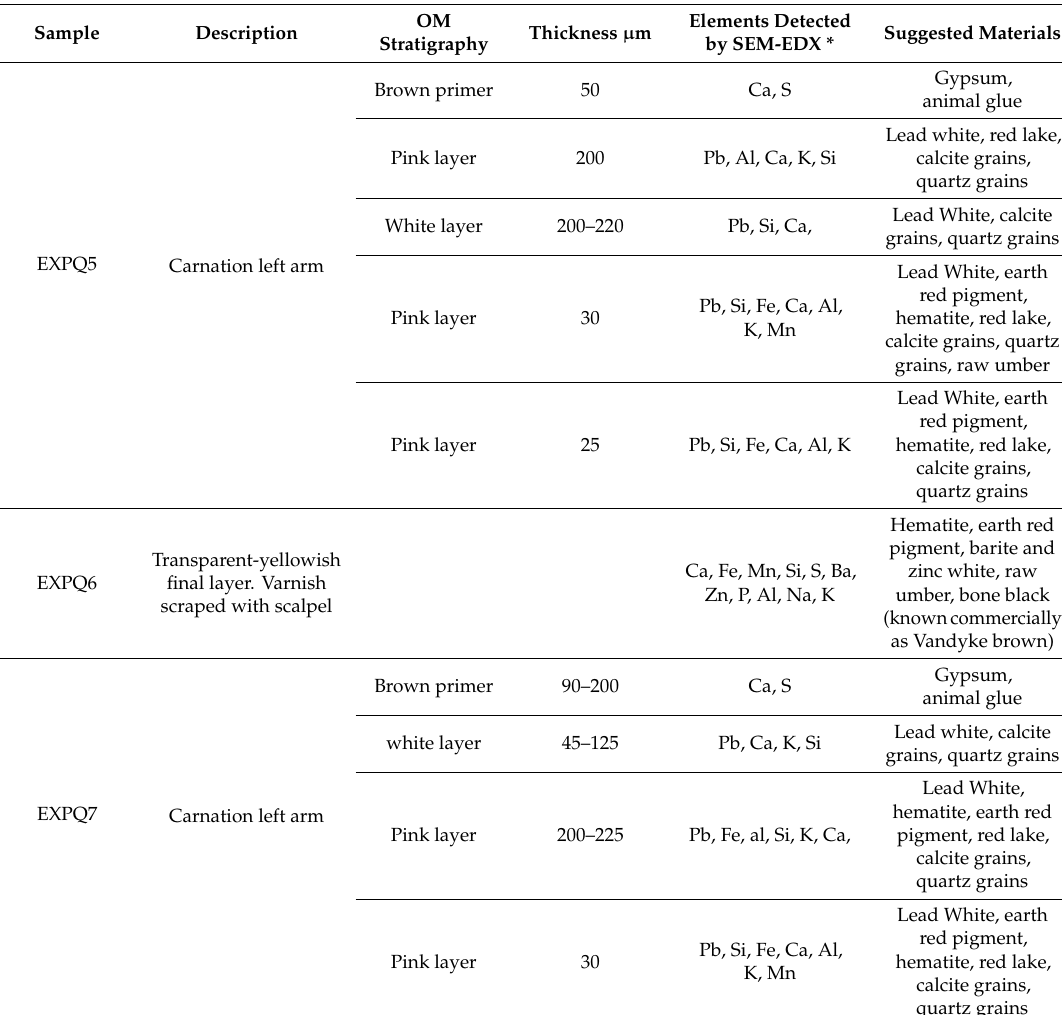
Table 1. Results of traditional techniques (OM, SEM-EDX,